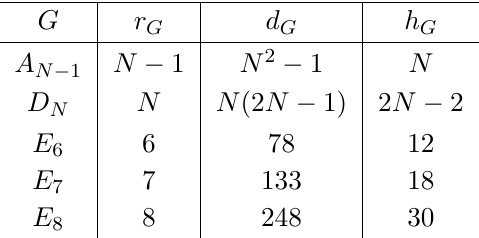
Table 1. Rank, dimension, and Coxeter numbers for the simply-laced Lie groups. Note the useful group theory identity d G = r G ( h G +